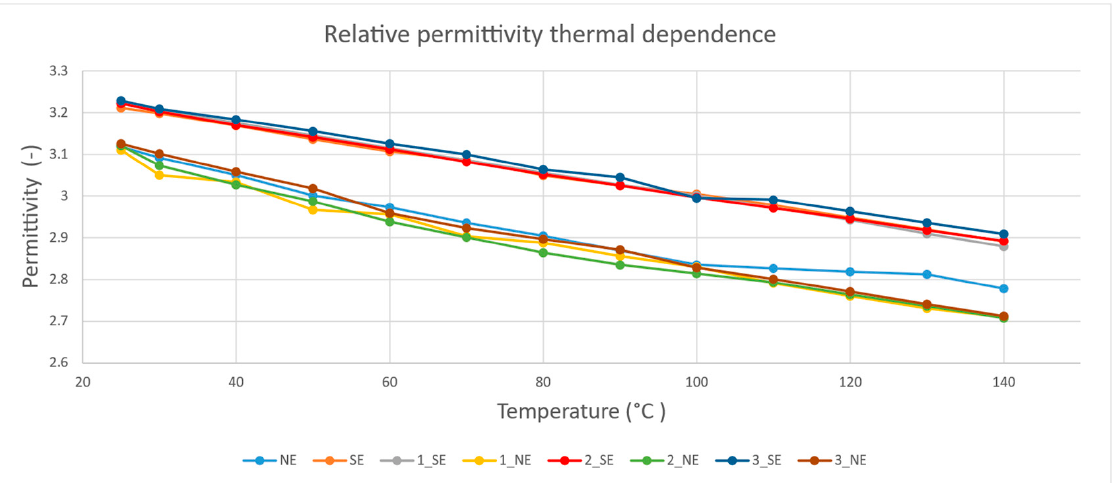
Figure 6. Relative permittivity thermal dependence (from 25 °C to 140 °C) of all examined fluids. The permittivity was measured at 50 Hz frequency with an electrical stress of 1 kV/mm.